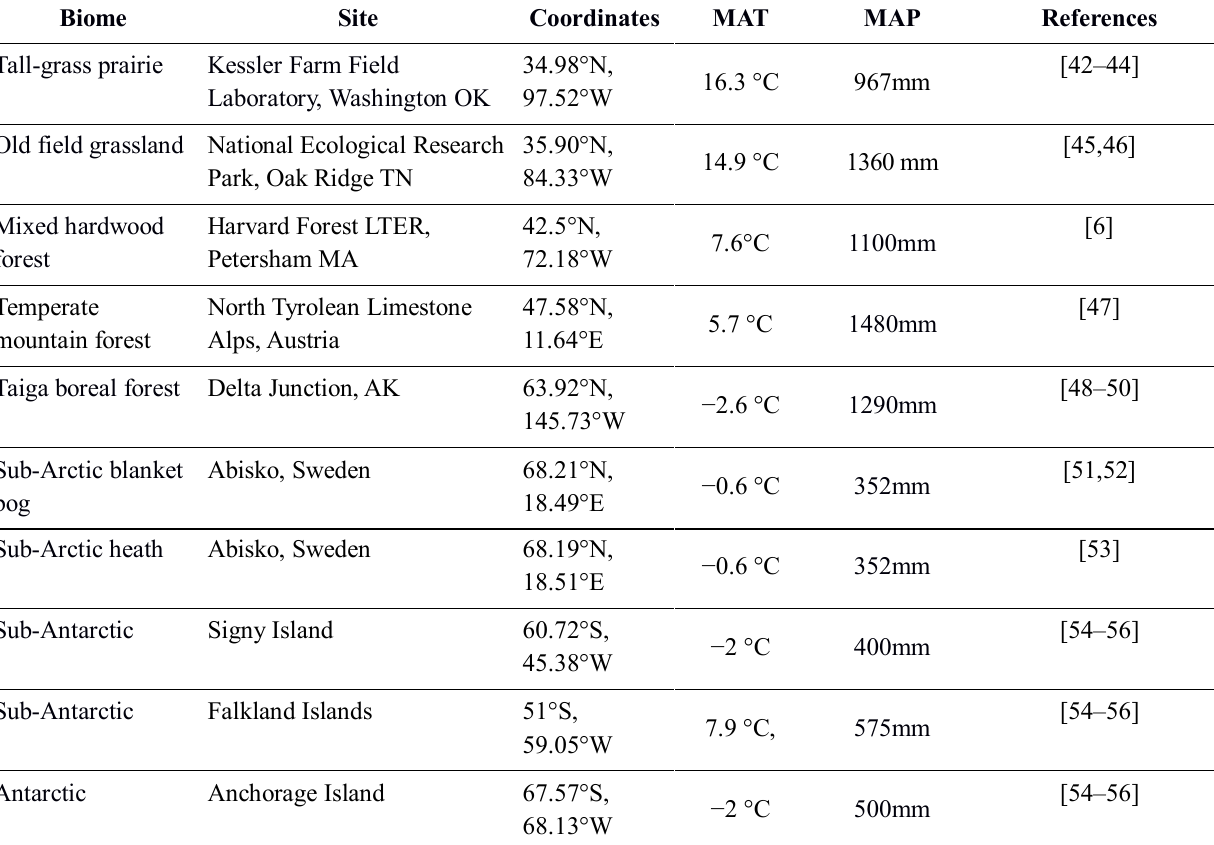
Table 1 . Geographic and climatic data for sites compared in this